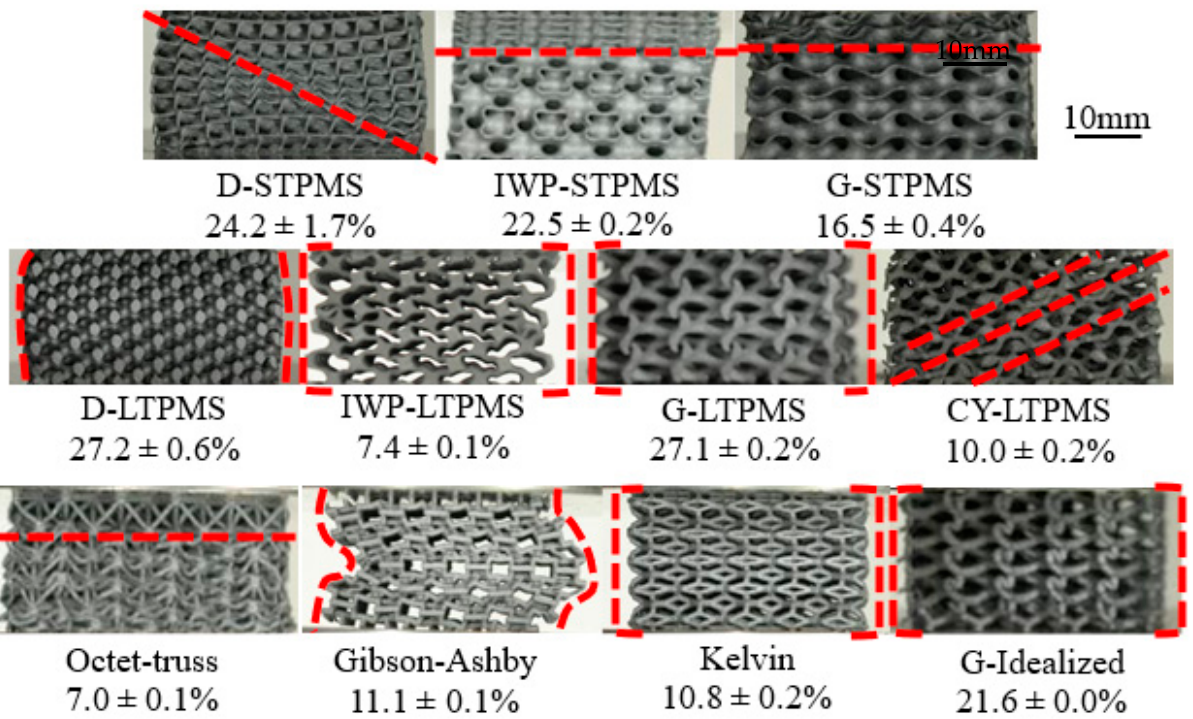
Figure 7. Deformation behavior of the various 3D-printed lattices at 50% strain level with their corresponding measured relative densities.